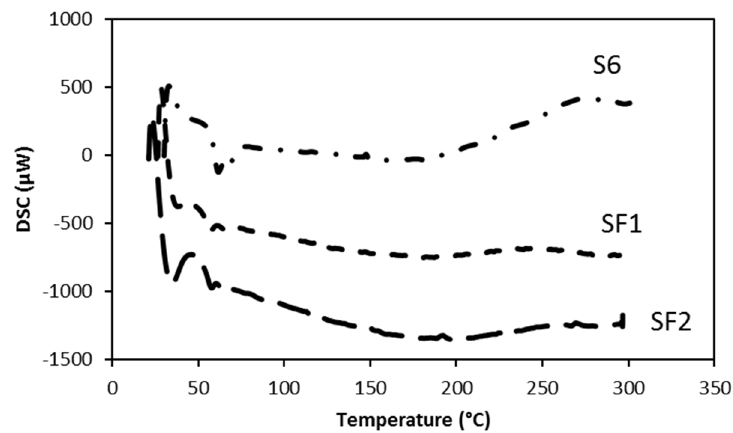
Figure 8. Comparison of the DSC behaviors of S6, SF1, and SF2 samples at the same weight (5 mg).